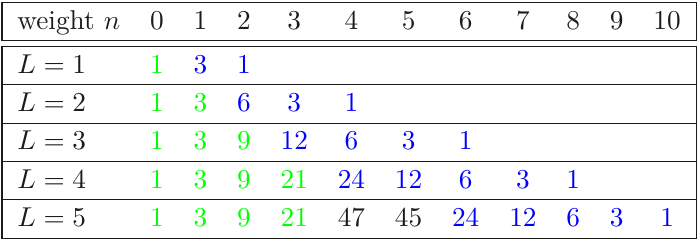
Table 2. The same as table 1, but for E ( L ) instead of E ( L )